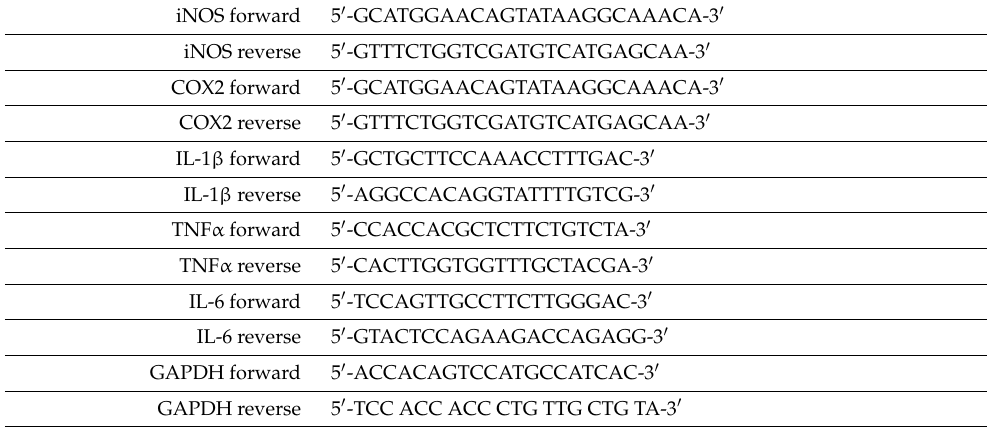
Table 1. List of